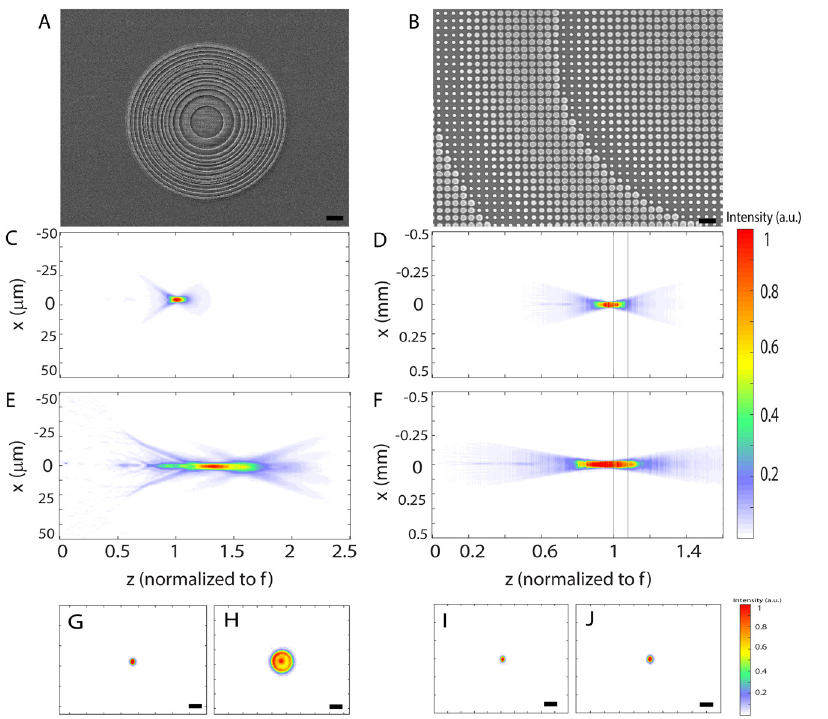
Figure 1: Scanning electron micrograph (SEM) of (A) inverse-designed EDOF meta- optics, (B) zoom-in SEM on inverse- designed EDOF meta-optics showing sili- con nitride scatterers forming the EDOF metalens; the scale bars correspond to 10 μ m(A)and1 μ m(B),(C – F)experimentally measured fi eldpro fi lealongopticalaxisfor traditional (C, D) and inverse-designed EDOFmetalenses (E,F)withfocallengthsof (C, E) f = 100 μ m, (D, F) f = 1 mm, (G – J) the PSFs of 1 mm aperture traditional metalens (G, H) and EDOF metalens (I, J) at two different depths correspond to (D, F). Scale bars, 50 μ m.